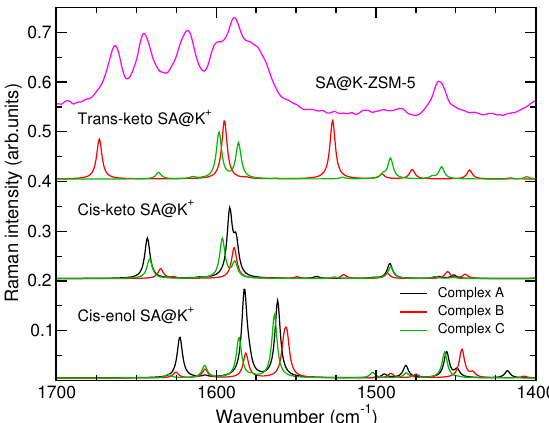
Figure 6. Calculated Raman spectra of SA@K + complexes and the experimental spectrum of SA@K-ZSM-5 sample in the zone 1400–1700 cm − 1 . No scaling factor was applied to the peak intensity in the computed